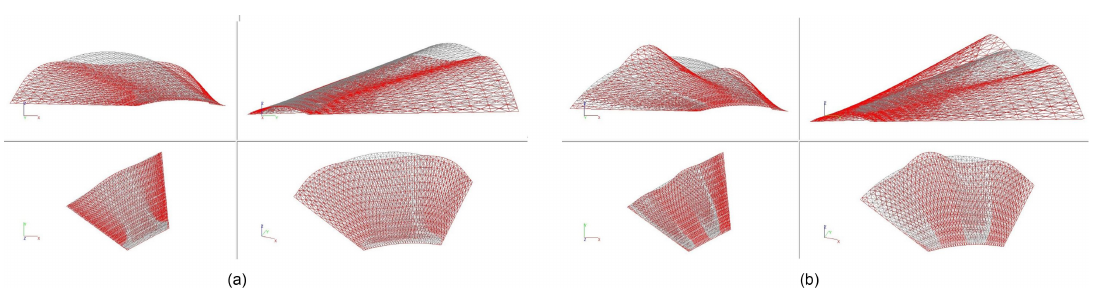
Figure 7: The deformation scheme of conoid shell